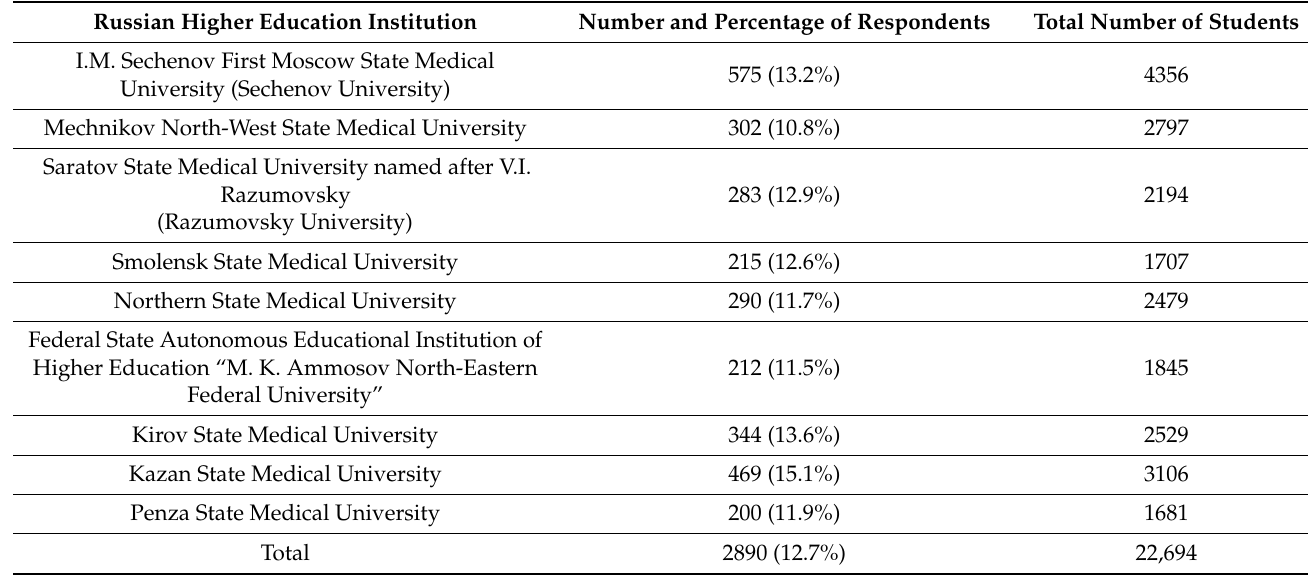
Figure 2. Sample size count: ( a ) ‘classic’ formula for counting; ( b ) formula and counting process for present study. Table 1. Number and percentage of surveyed medical students.